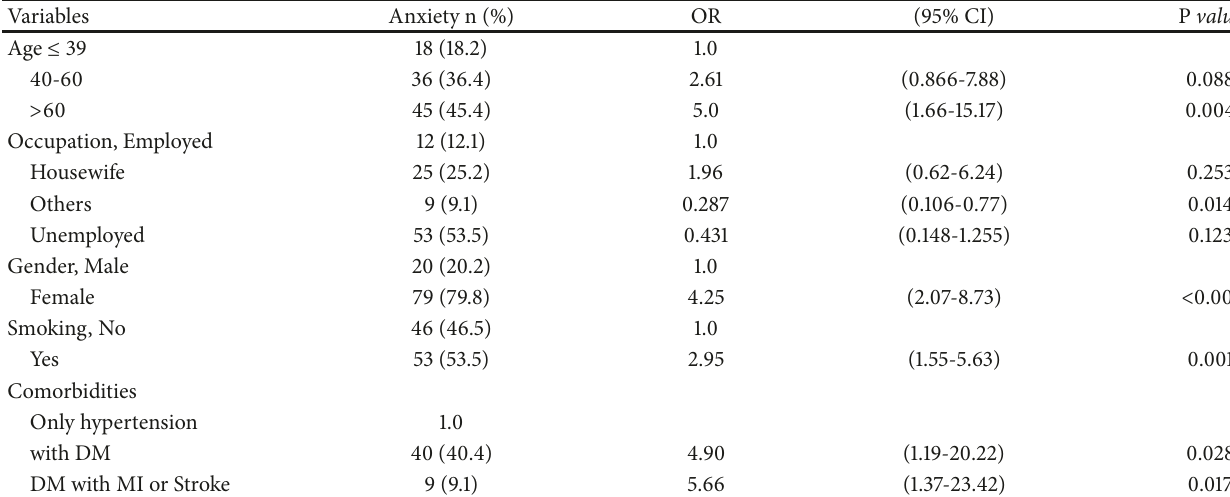
Table 3: Associated factors with anxiety among hypertensive patients.